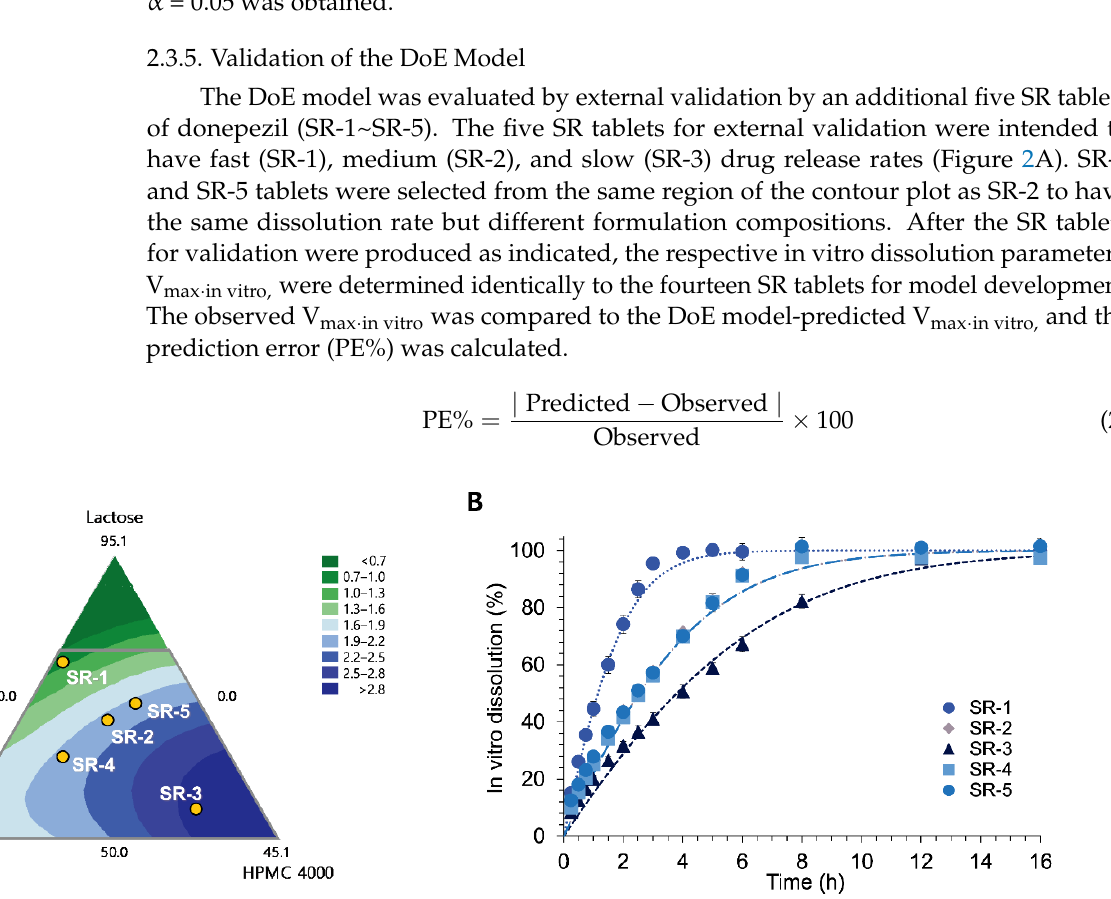
Figure 2. Five experimental points of donepezil SR tablets for the DoE validation on the contour plot ( A ), and their respective in vitro dissolution profiles at pH 1.2 ( B ).